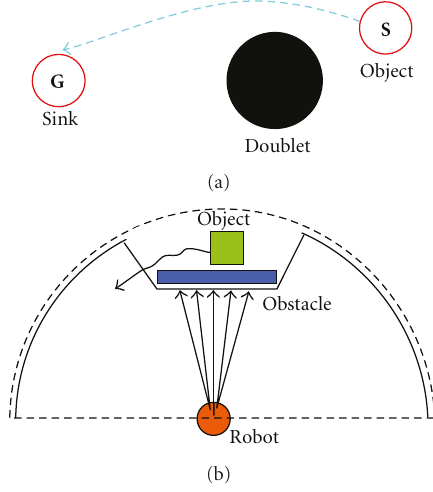
Figure 3: Illustrations of the stream field-based motion model and real environment. (a) Stream field-based motion model. (b) A real